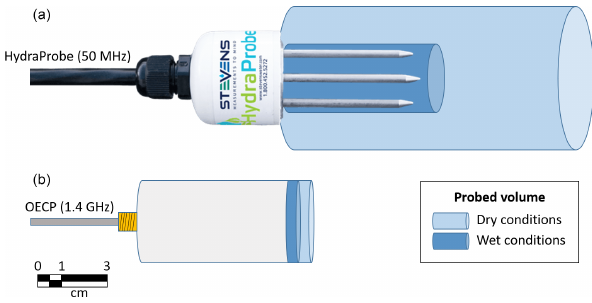
Figure 2. Approximate probed volume (blue) of the HydraProbe (a) and OECP (b) for relatively dry and wet soil conditions. The probed volume is also influenced by soil